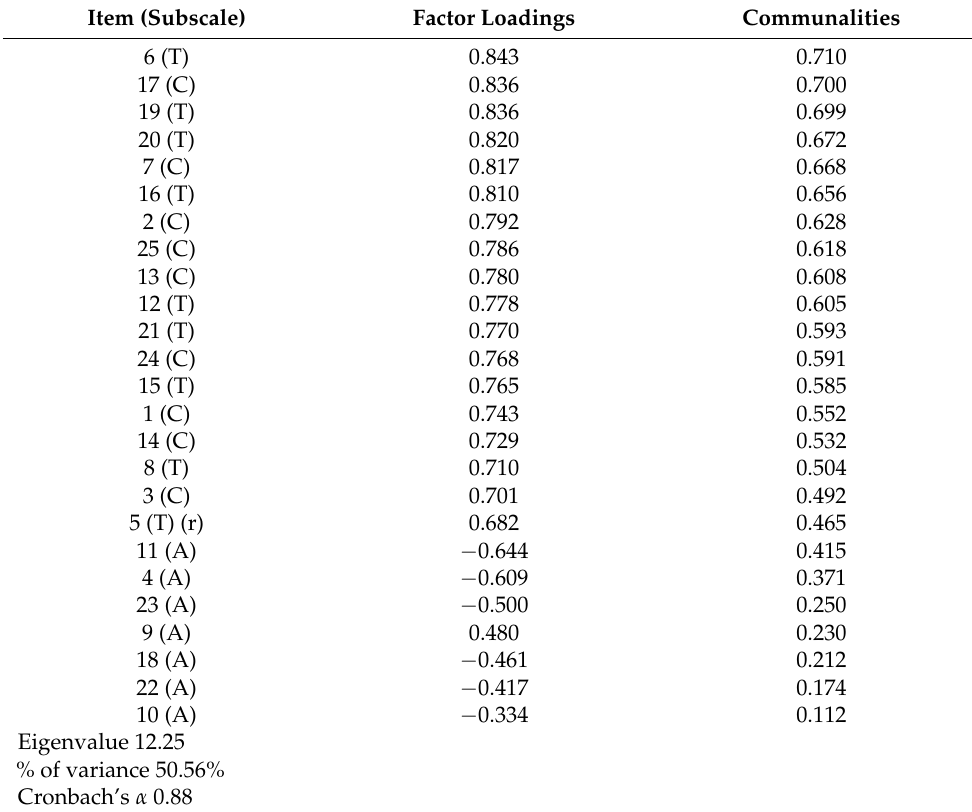
Table 1. Exploratory Factor Analysis Results ( N =